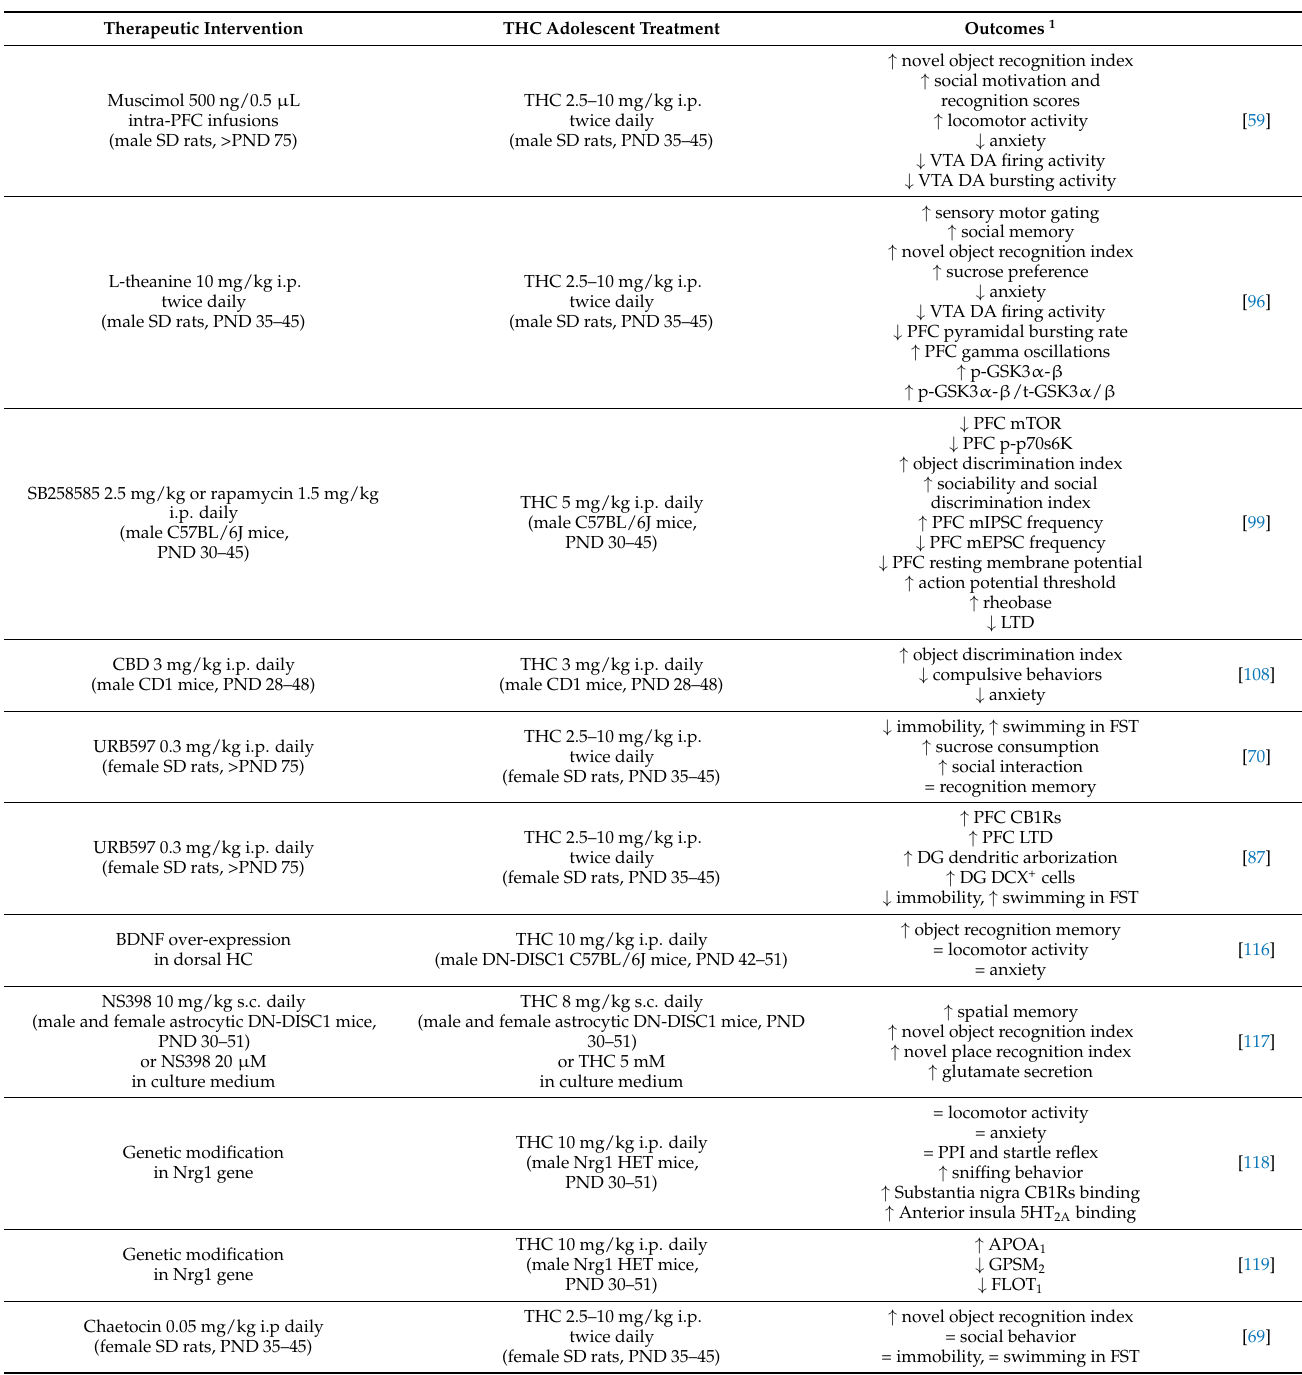
Table 1. Summary of pre-clinical findings on therapeutic approaches for abnormalities induced by chronic THC during